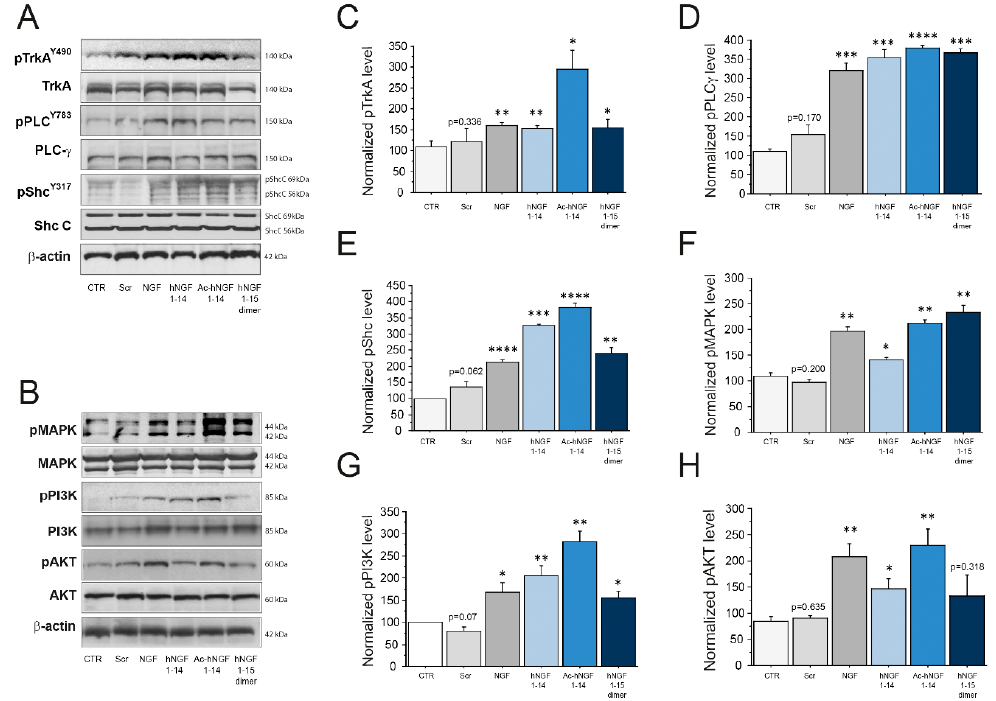
Figure 1. Activation of the NGF-TrkA signalling pathway in cholinergic neurons by hNGF1–14